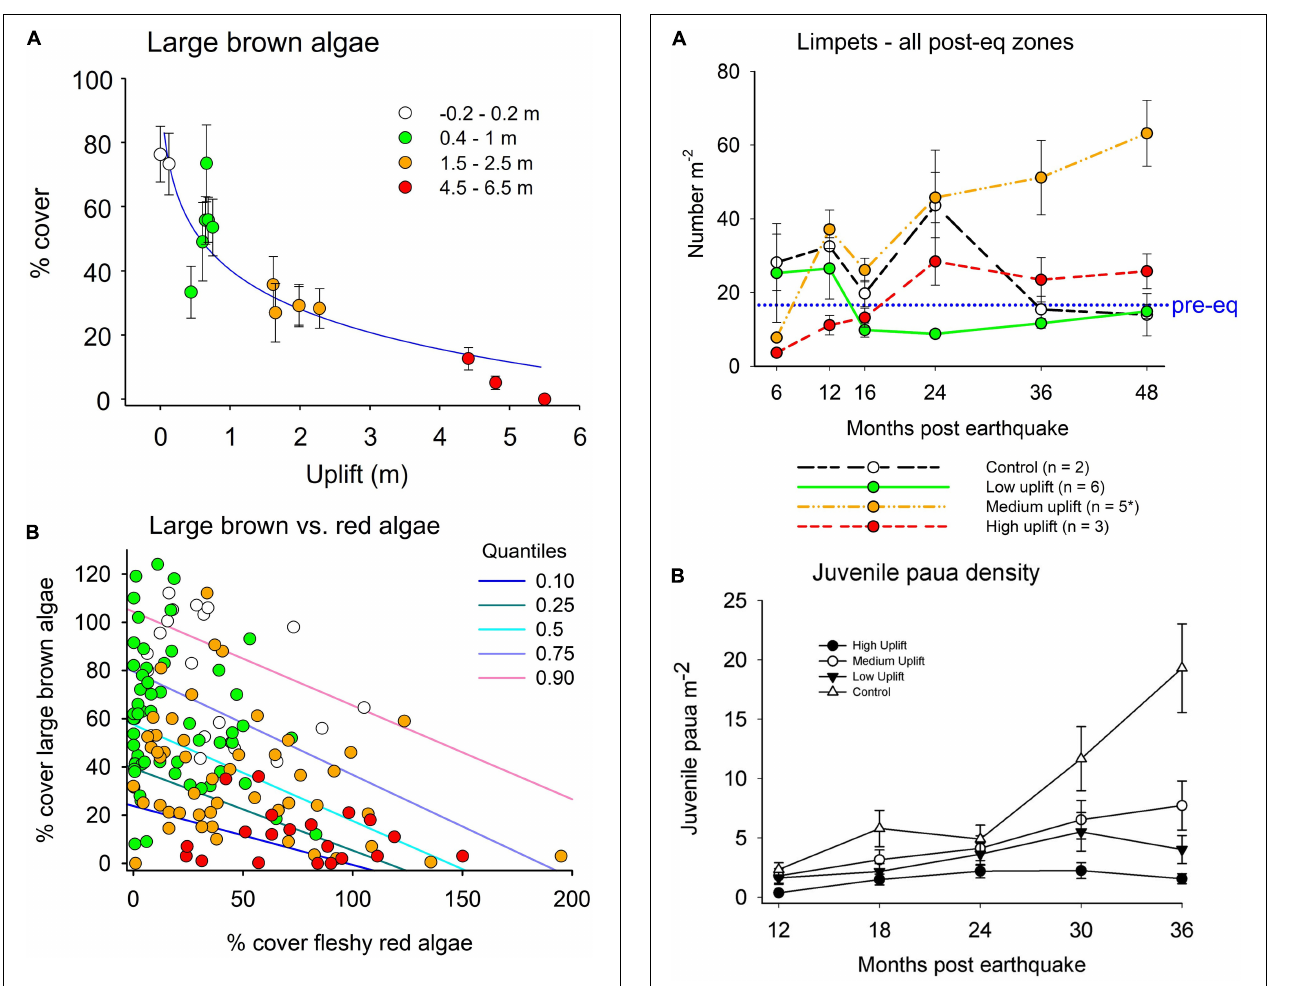
FIGURE 7 | (A) The relationship between percentage cover ( ± SE) of large brown algae across degrees of uplift. (B) Relationship between the abundance of large brown and fleshy red algae 3 years after the earthquake estimated through a quantile regression model. Regression lines are displayed for significant relationships. Symbol colors indicate different levels of uplift (white = no uplift, green = low uplift, yellow = medium uplift, red = high uplift). Data from the high-uplift site of Waipapa Bay 1, where both large brown and fleshy red algae were not present, were not included in this analysis.